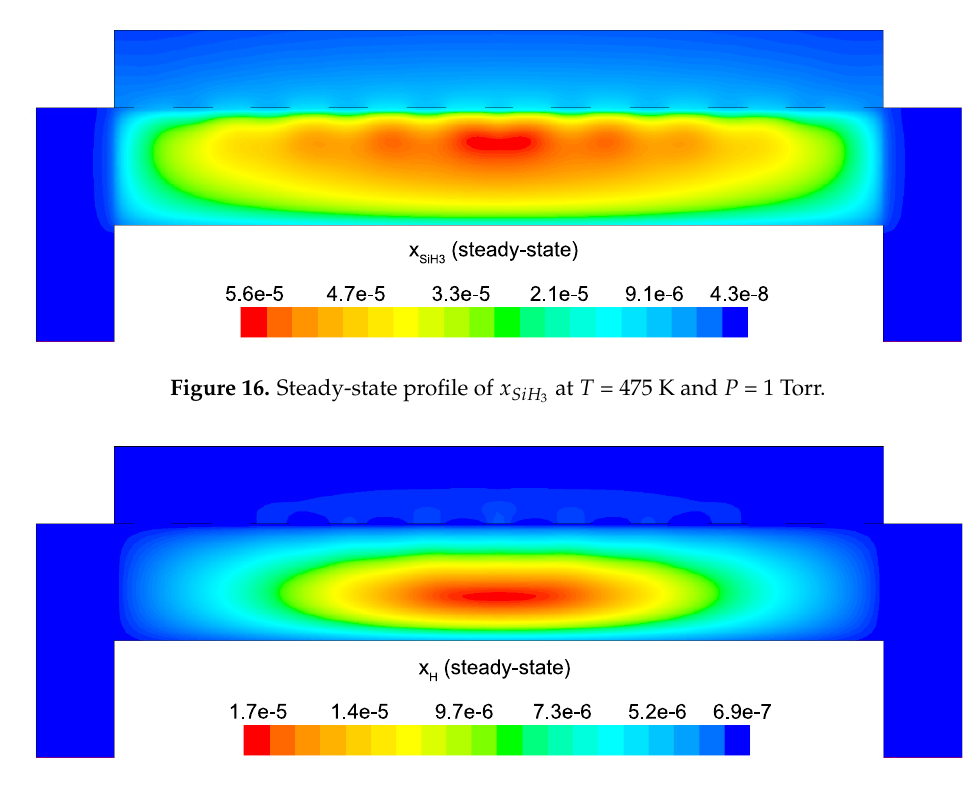
Figure 17. Steady-state profile of x H at T = 475 K and P = 1